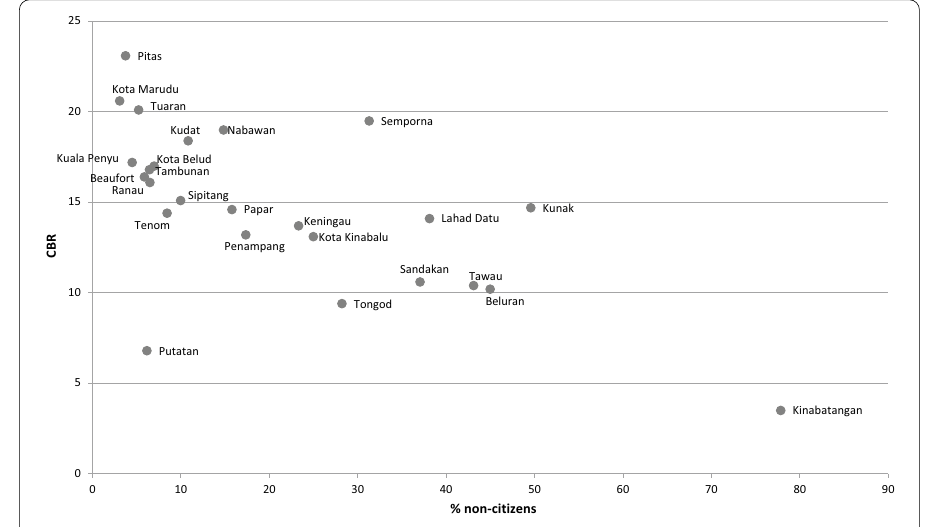
Fig. 3 Percentage of non-citizens and CBR by district in Sabah, 2019. Spearman correlation coefficient 0.646, p < 0.001. Sources: Vital statistics, Malaysia, 2020; My local stats, Sabah, 2019 (DOSM, = − 2020d, f)